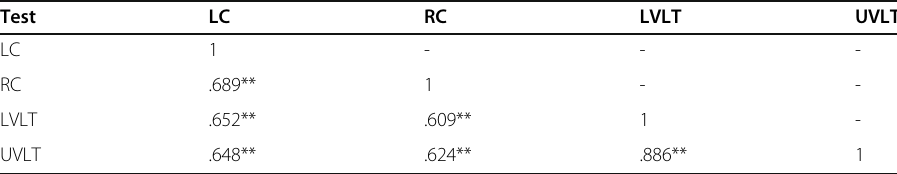
Table 3 Pearson correlations among scores on listening and reading comprehension and orthographic and lexical knowledge of vocabulary ( N = 234) Test LC RC LVLT UVLT LC 1 - - - RC .689** 1 - - LVLT .652** .609** 1 - UVLT .648** .624**